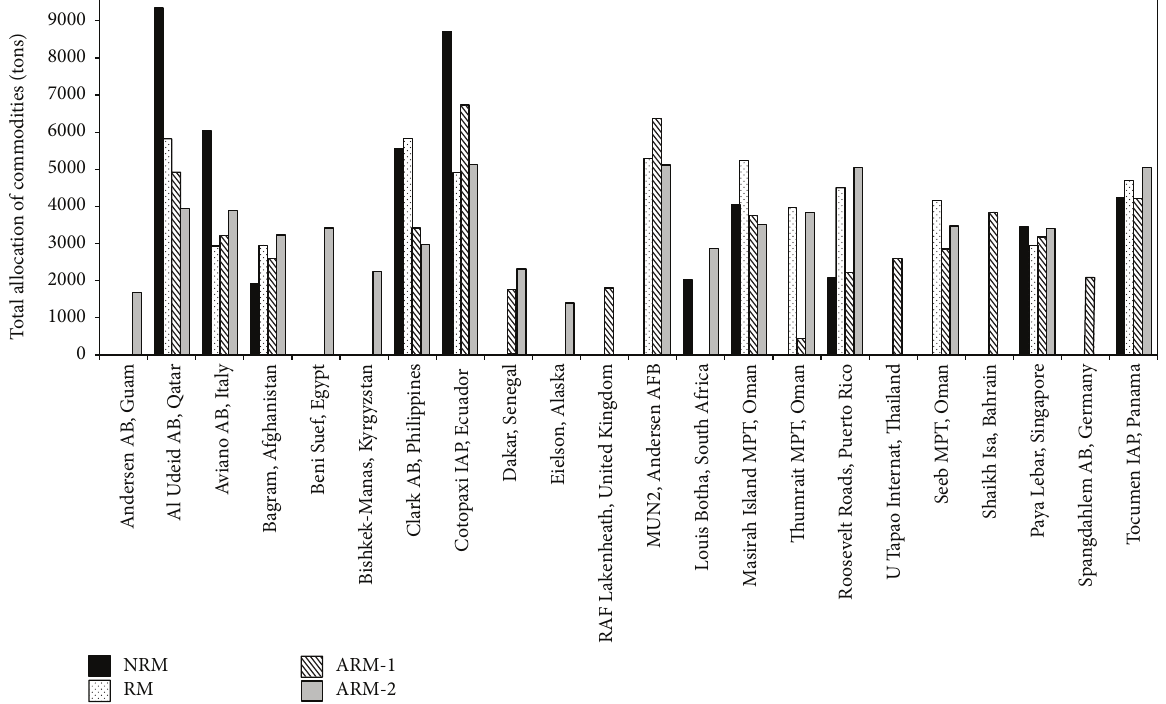
Figure 3: Allocation of commodities to FSLs, across all model runs.